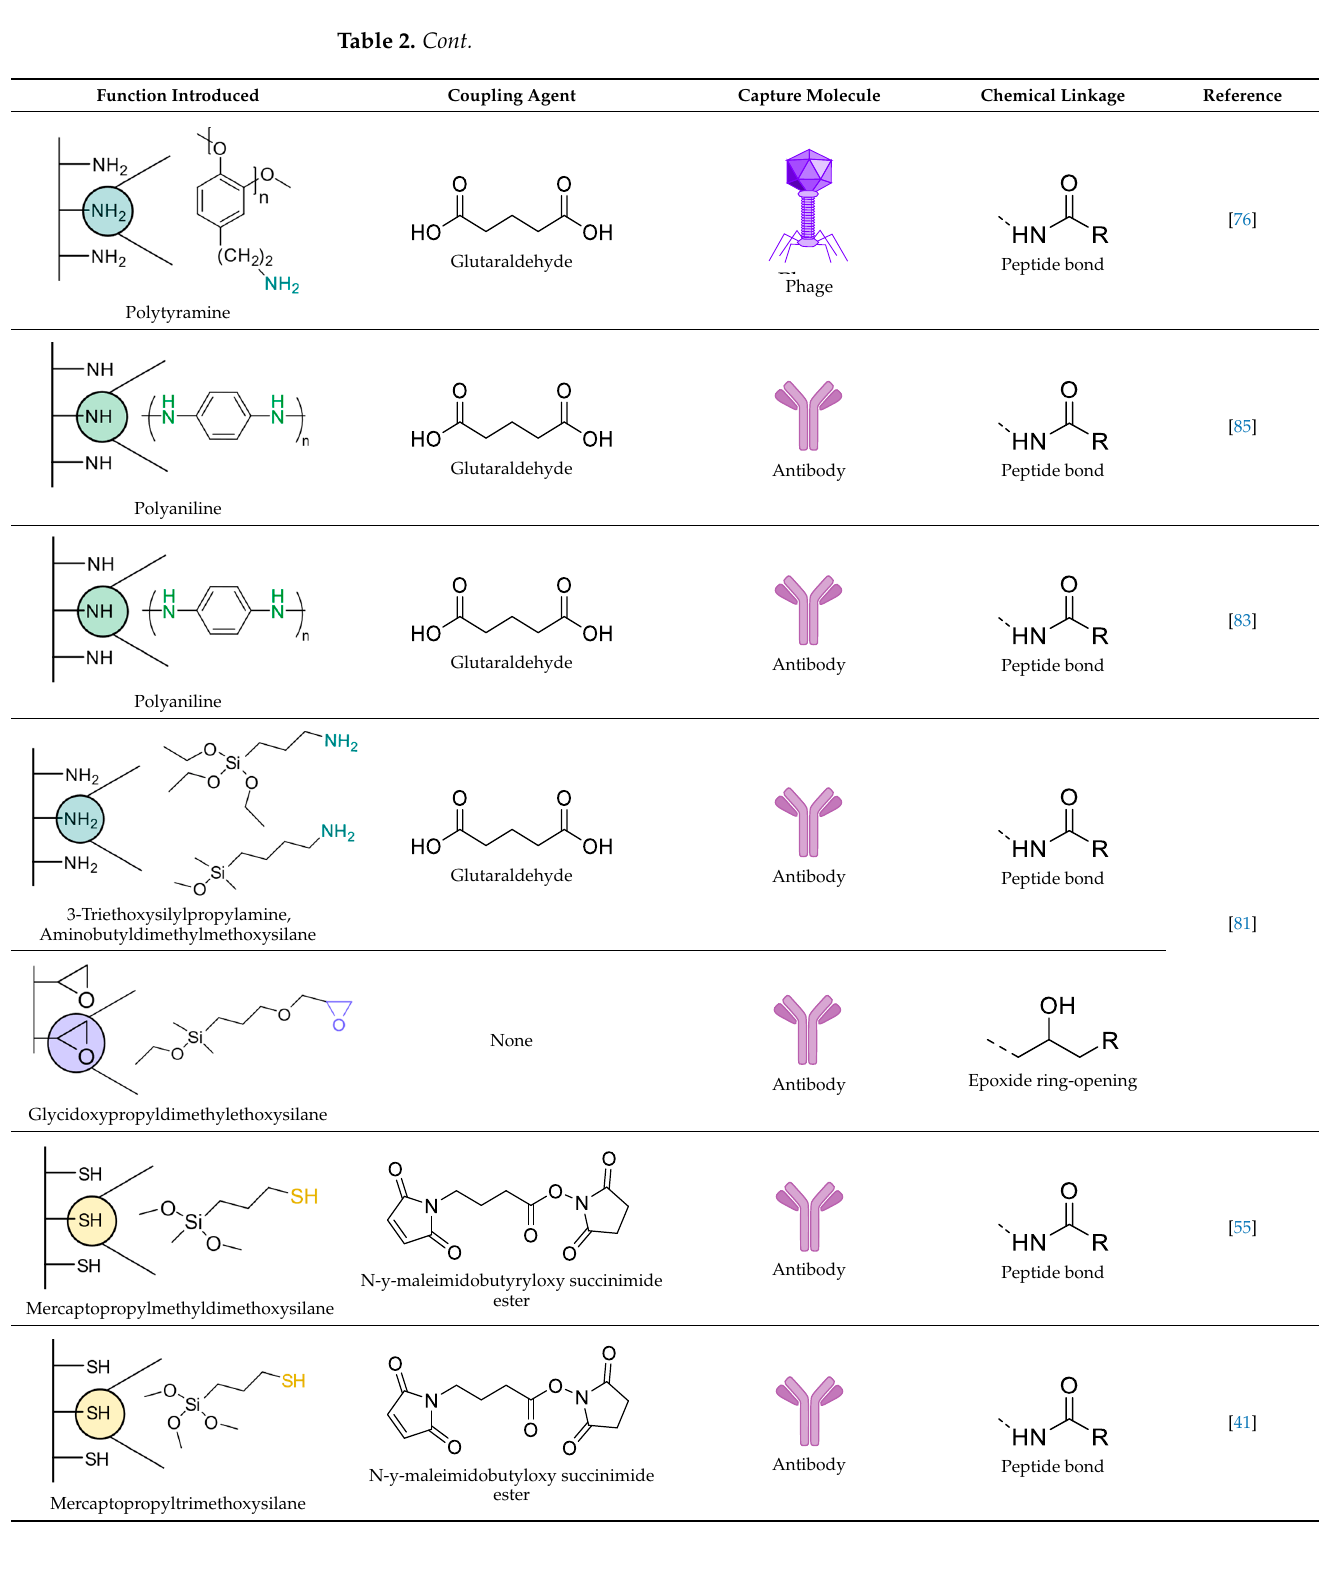
Table 2. Methods reported for the covalent conjugation of capture biomolecules on insulating lay- ers. R: Capture molecule. Table 2. Cont.